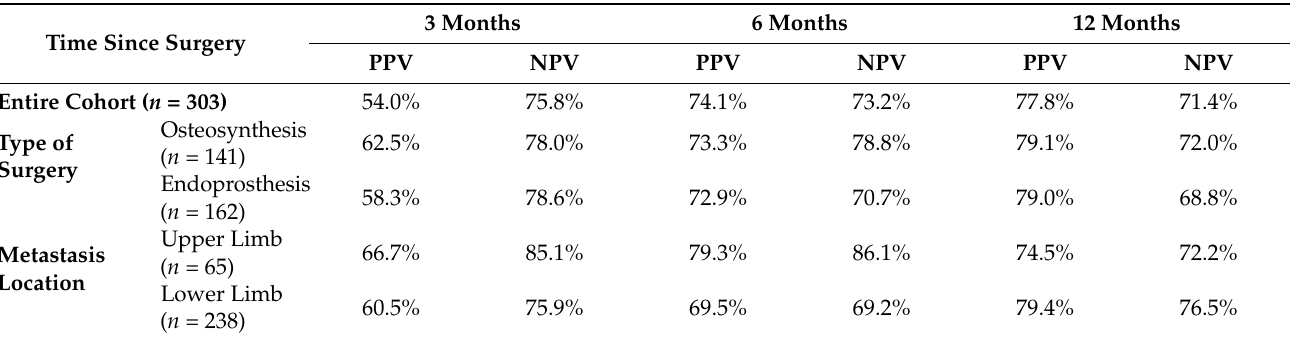
Figure 2. Accuracy of survival prediction for all patients treated surgically ( n = 303) for bone metastases of the appendicular skeleton at 3, 6 and 12 months with receiver operator characteristic area under the curve (ROC AUC), based on the 2013-SPRING model. Table 3. Positive predictive values (PPVs) and negative predictive values (NPVs) for the entire cohort ( n = 303), as well as treatment (osteosynthesis vs. endoprosthesis) and metastasis location subgroups (upper vs. lower limb).